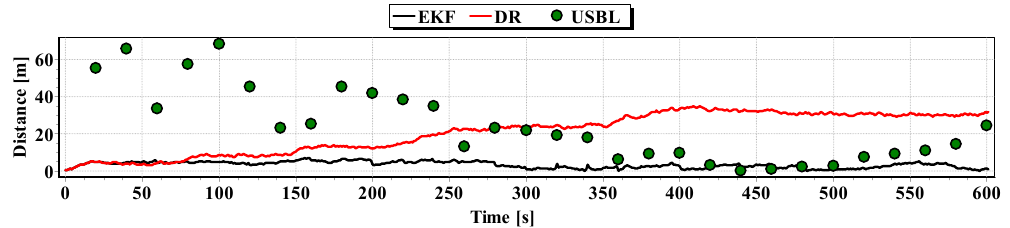
Figure 21. Graph of the reference position distance from the position estimated by EKF and DR methods and determined by the USBL system (single passage).